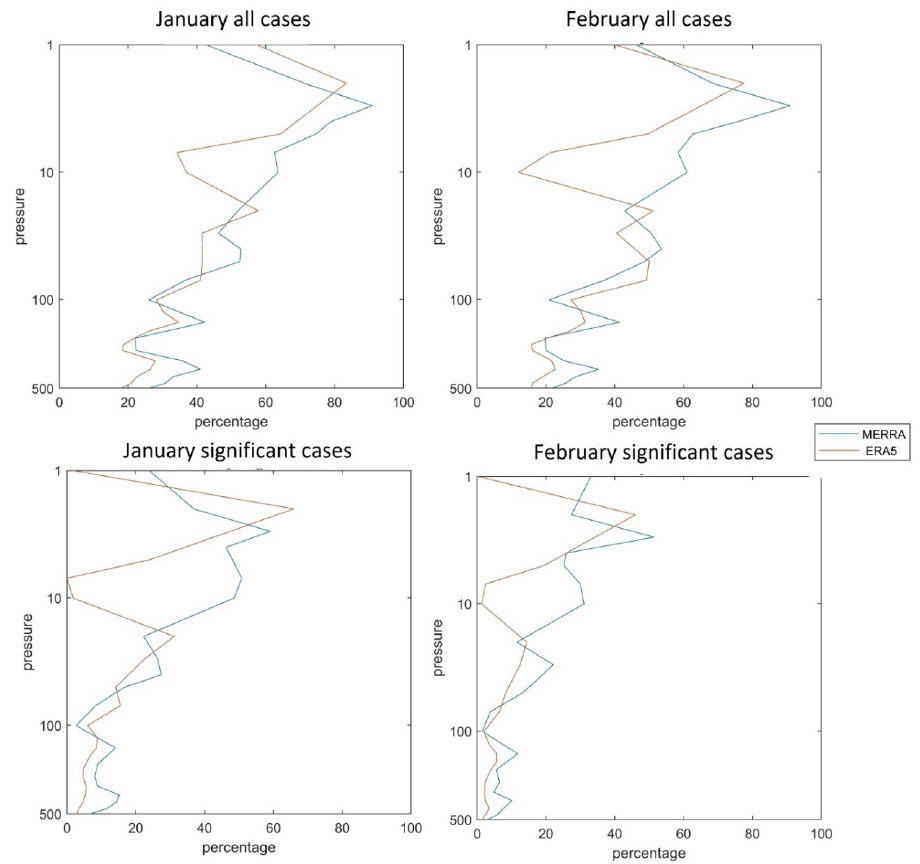
Figure 6. Vertical profiles of number of grid points with discontinuities (in percentage) for ERA5 and MERRA2 in January (left panels) and February (right panels). Significant cases mean the application of variance condition.